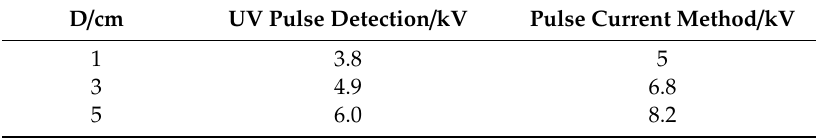
Table 2. UV pulse detection and pulse current method compared to the initial discharge voltage U